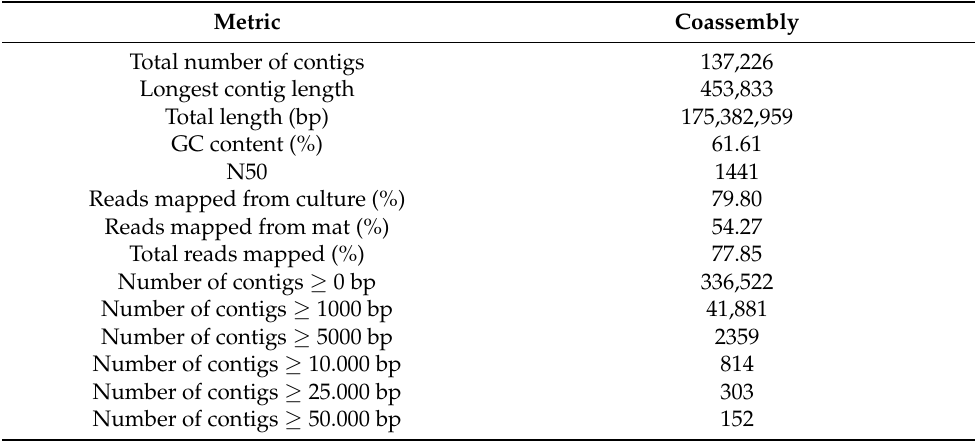
Table 2. Quality metrics of coassembly generated from sequencing of the mat and laboratory culture samples. All statistics are from QUAST v4.4, except for mapping statistics which were generated from samtools v1.9 using the flagstat